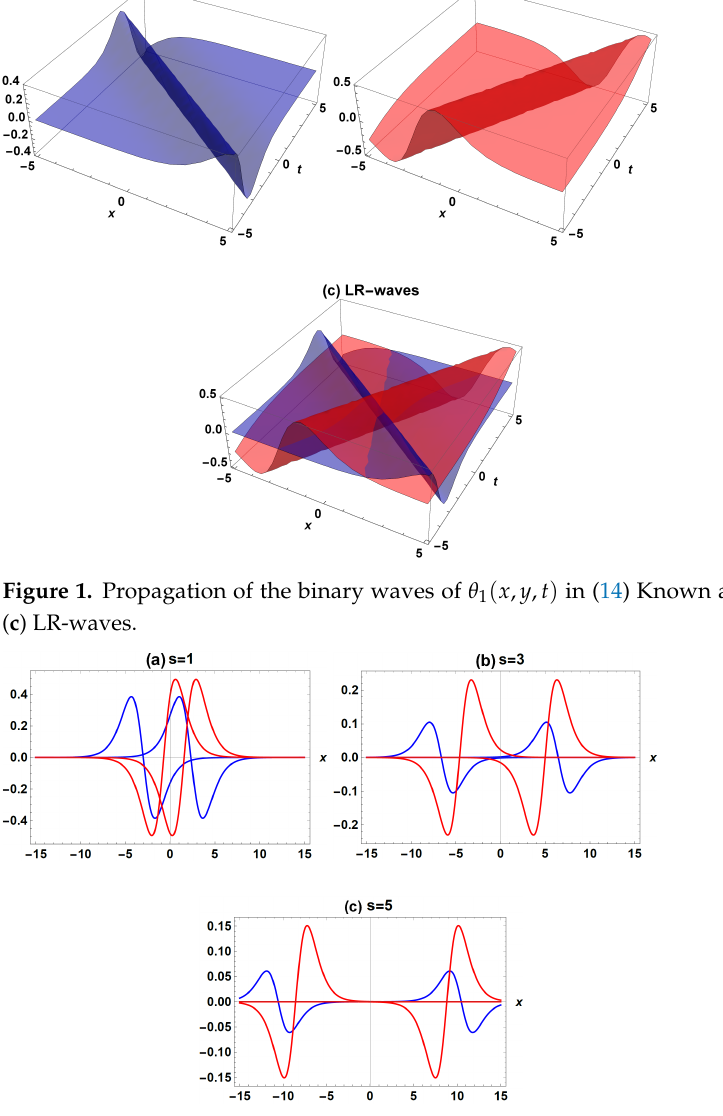
Figure 2. Interaction of the binary waves of θ 1 ( x , y , t ) in (14) for different values of the phase–velocity ( a ) s = 1. ( b ) s = 3. ( c ) s =